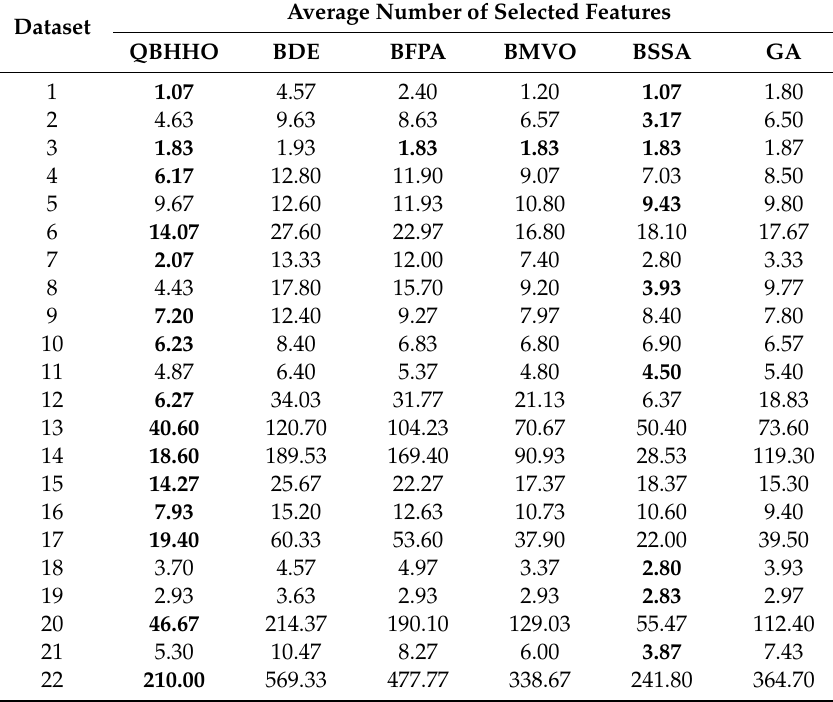
Table 14. Experimental result of the average feature size of six di ff erent